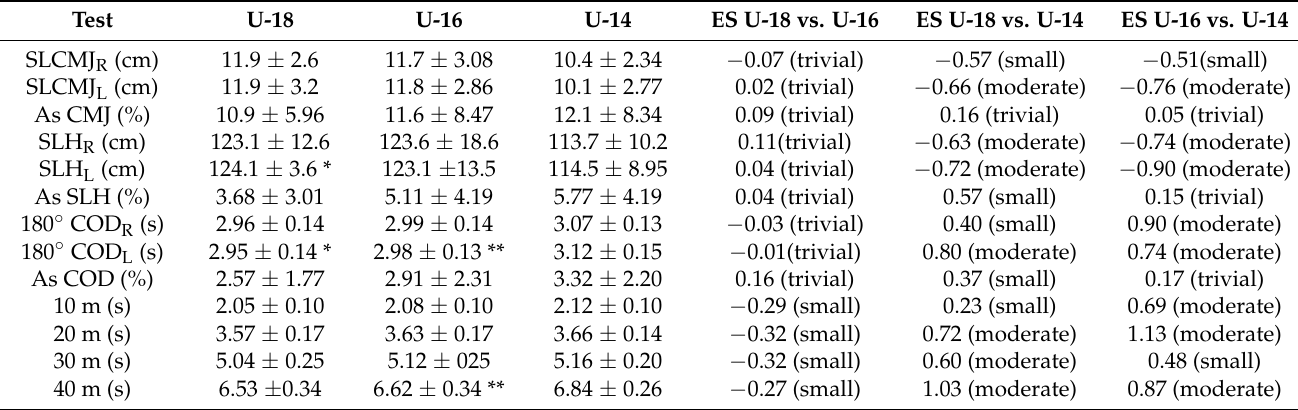
Table 2. Mean data ± standard deviation for each age group and effect sizes between